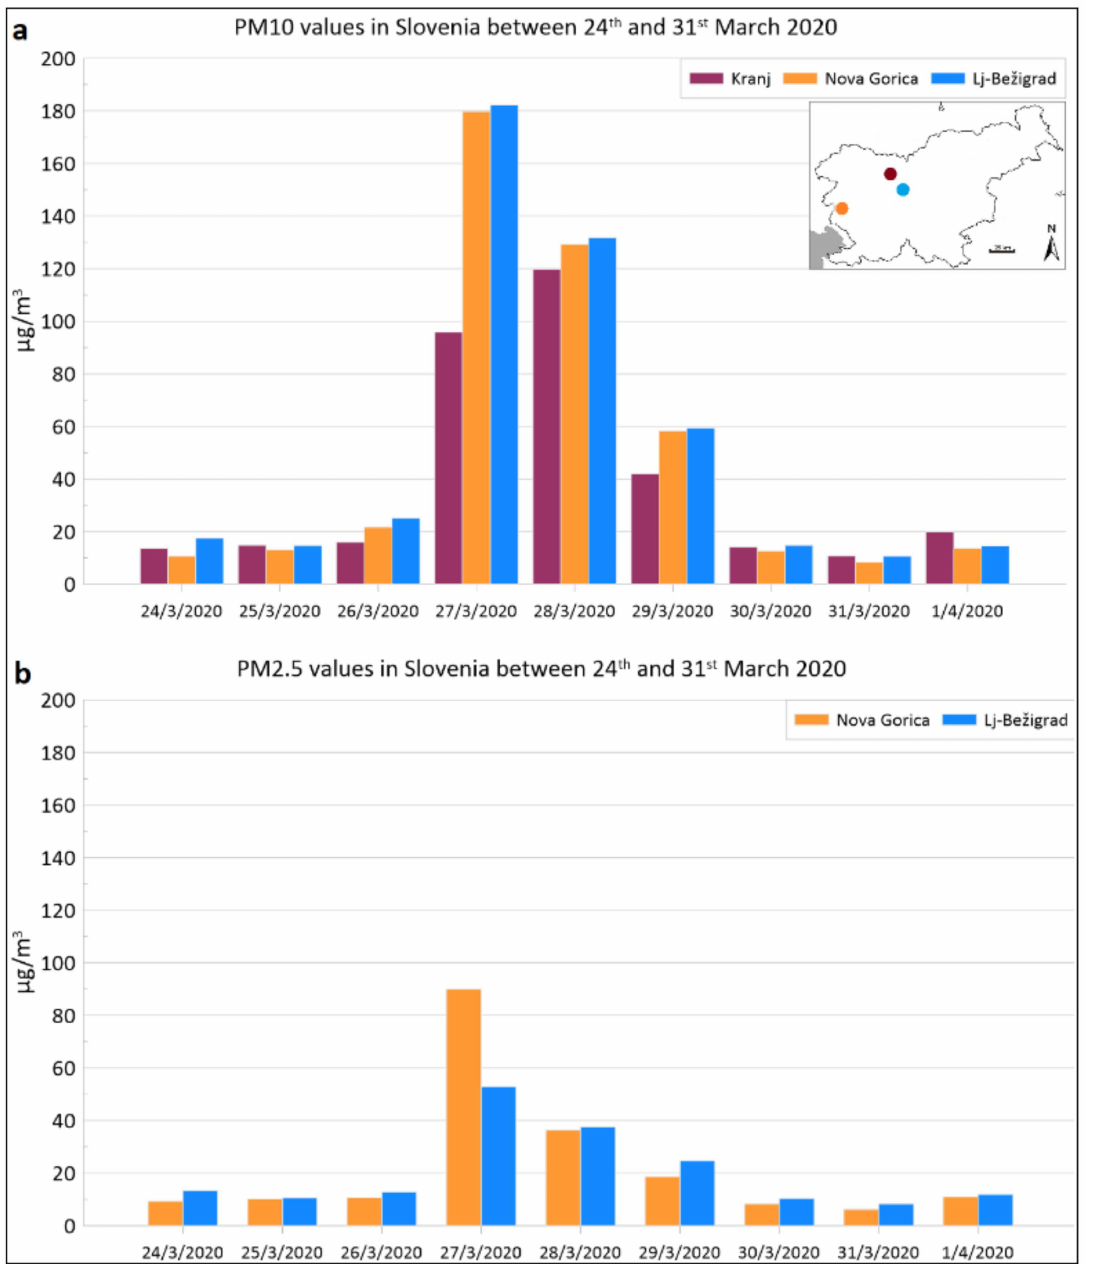
Figure 2. Daily PM10 ( a ) and PM2.5 values ( b ) in Slovenia measured in 3 stations (Ljubljana, Nova Gorica and Kranj) between 24th and 31st of March 2020, showing the influence of the 2020 dust event. Data was provided by Slovenian Environment Agency